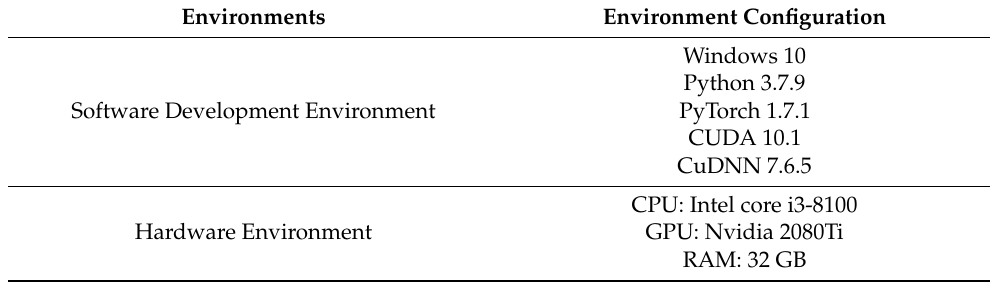
Table 1. The experiment environments.